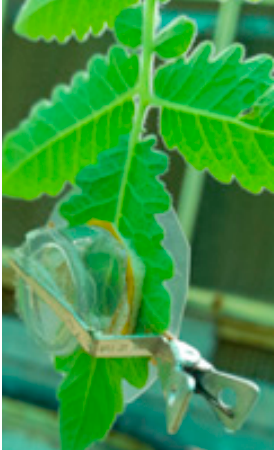
Figure 1. A clip leaf-cage with screened ventilated top.